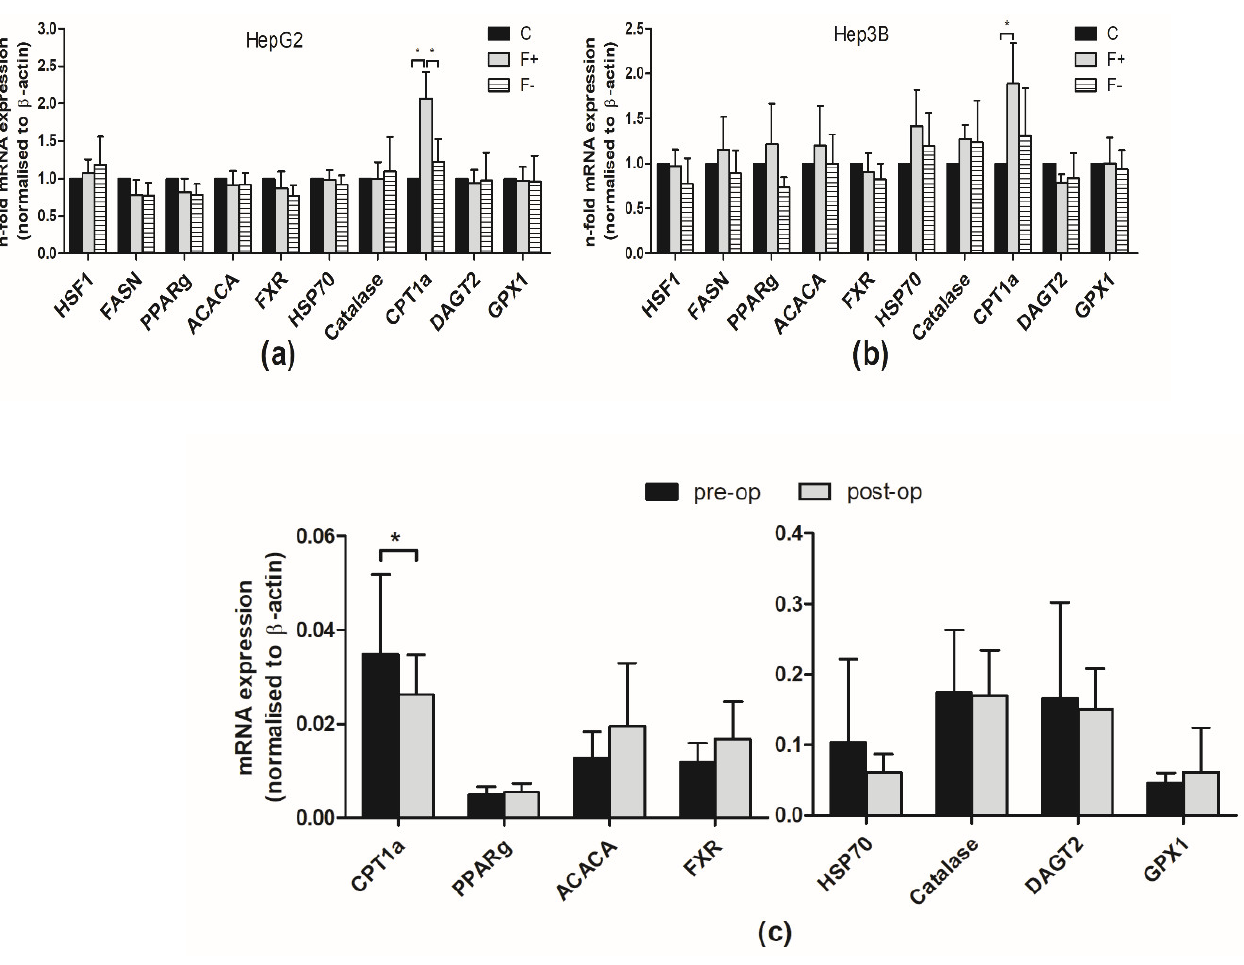
Figure 4. CPT1a is upregulated during fat accumulation. HepG2 and Hep3B cells were cultured as already described. Isolated total mRNA was subjected to reverse transcription and expression of indicated genes was analyzed by real-time PCR ( a , b ). For normalization, β -actin expression was analyzed. The figure displays the mean values of three independent experiments performed in duplicates ± S.D. * p -values < 0.05. Total RNA from liver tissues of 14 adipose patients undergoing bariatric surgery (pre-op) and of follow-up (post-op) liver biopsies from the same patients were isolated, reverse transcribed, and analyzed by qPCR for indicated gene expression ( c